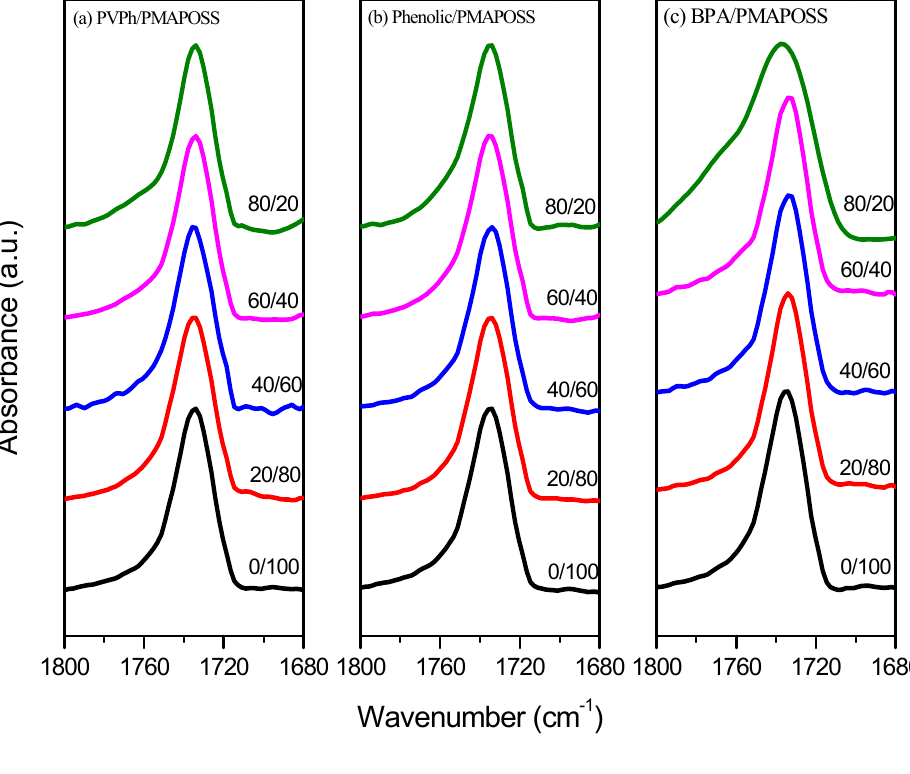
Figure 11. FTIR spectra (1800–1650 cm − 1 region) recorded at room temperature for ( a ) PVPh/PMA-POSS; ( b ) phenolic/PMA-POSS; and ( c ) BPA/PMA-POSS blends containing various PMMA